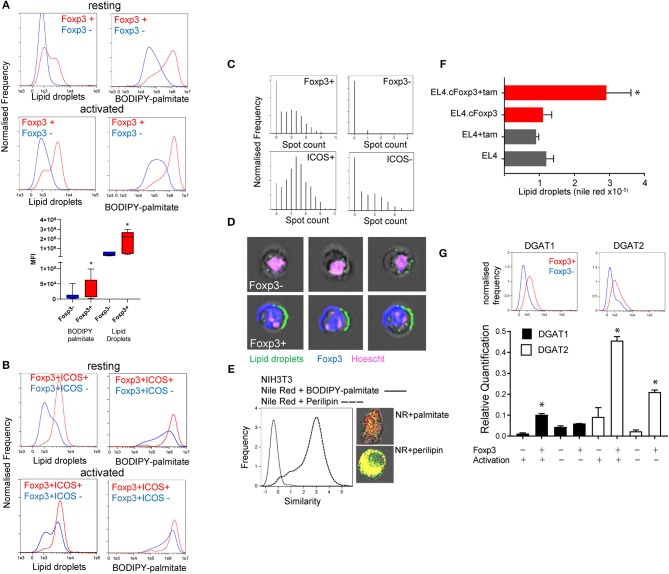
Foxp3 expressing T cells have elevated lipid droplet content. (A) Quantitation using Imagestream, of LDs with nile red staining, and palmitate uptake using BODIPY-labeled palmitate on resting and activated Foxp3+ and Foxp3- T cells from the same activation cultures from C57BL/6.Foxp3 hCD2/CD52 knock in mice. The bar chart shows the composite data from 8 separate experiments. *p < 0.05 by ANOVA. (B) Measurement using Imagestream, of LDs and fluorescent palmitate uptake in resting, and activated CD4+Foxp3+ICOS+/- cells from the same cultures. (C) Top panels; Measurement of LD number in CD4+Foxp3+ and Foxp3- cells using the Imagestream “spot count” feature. Bottom panels; Measurement of LD number in CD4+Foxp3+ICOS+ and ICOS- cells. (D) Representative images of Foxp3- and Foxp3+ cells showing bright field, Hoescht, Foxp3, and nile red staining analyzed with Imagestream. (E) Measurement of proximity (“Similarity” feature in Imagestream) of nile red staining and perilipin, histogram and bottom image panel, compared to nile red and BODIPY-palmitate, histogram and upper image panel, in NIH3T3 cells. (F) Measurement of LD by nile red staining in a tamoxifen-inducible Foxp3 T cell line EL4.cFoxp3 or the parental cell line EL4 in the presence and absence of 4'OH tamoxifen. Error bars represent standard error of the mean, *p < 0.05. Representative of three separate experiments. (G) Expression of DGAT1 and DGAT2 protein (top panels) and mRNA transcripts in Foxp3+ T cells and Tconv from B6.KI mice. For mRNA analysis cells were analyzed straight after isolation or after 24 h activation with anti-CD3/28 beads. Error bars represent standard error of the mean, *p < 0.05. Representative of three separate experiments.